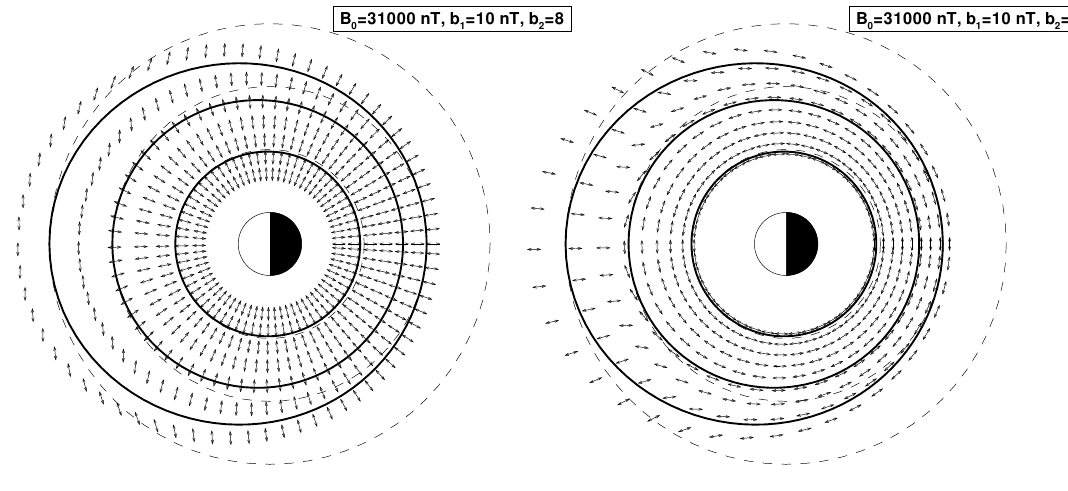
Fig. 6. Electric field polarizations in the equatorial plane for the two Alfv´enic eigenmodes. Left panel: mode with radial electric field polarization at midnight; right panel – with azimuthal electric field at midnight. Thick solid lines show the contours of constant B initiated at r = 3, 5, and 7 at noon. Dashed lines are circles of constant radius with r = 3, 5, and 7. Note the sudden change of the polarization along the noon meridian (see text for details).